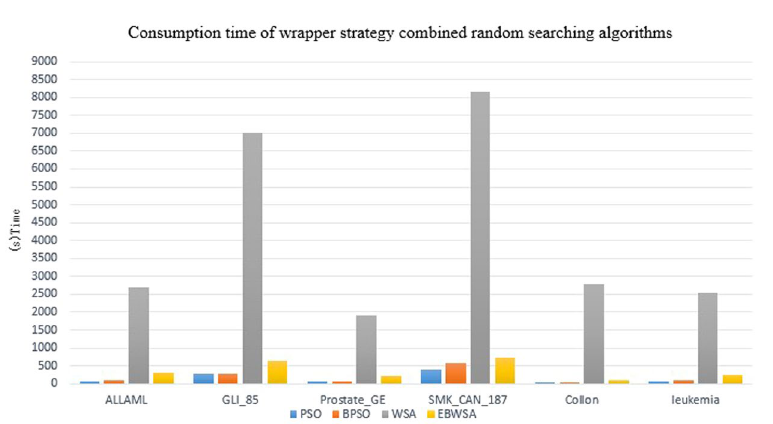
Figure 4. Consumption time by each swarm intelligence algorithm (i.e. PSO, BPSO, WSA, and